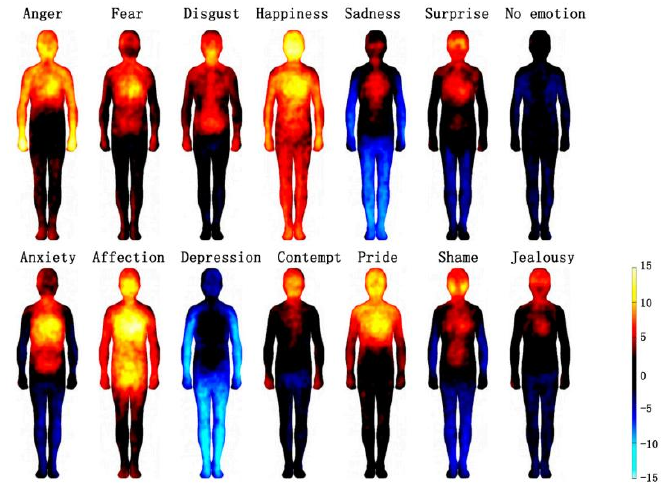
Figure 8. Emotion and energy activation of the human body (The colorbar indicates the t-statistic range where pixel intensities reflect statistically significant experienced bodily changes associated with each emotional state). Reprinted from Ref. [30].